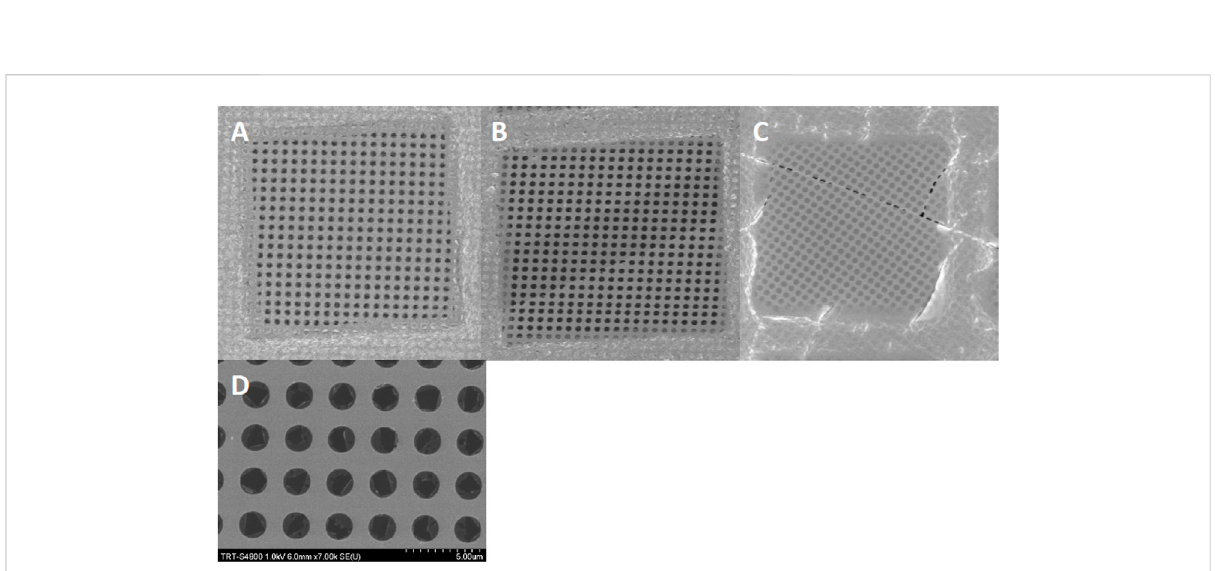
FIGURE 2 SEMimagesofaQuantifoil300meshcarbongridwitha2 nmcontinuouscarbonlayer.AquicklookatthegridwithsimplebinocularsorSEMat lowmagni fi cation(x700)doesn ’ tshowcleardefectsinthegrid(Figure2A).Amorecarefulanalysisofthegriddisplayspatcheswheretheextracarbon layer is sometimes missing (Figure 2B) or contains irregular holes (Figure 2C). At higher magni fi cation (x7000), the extra carbon layer is disrupted in each hole. (Figure